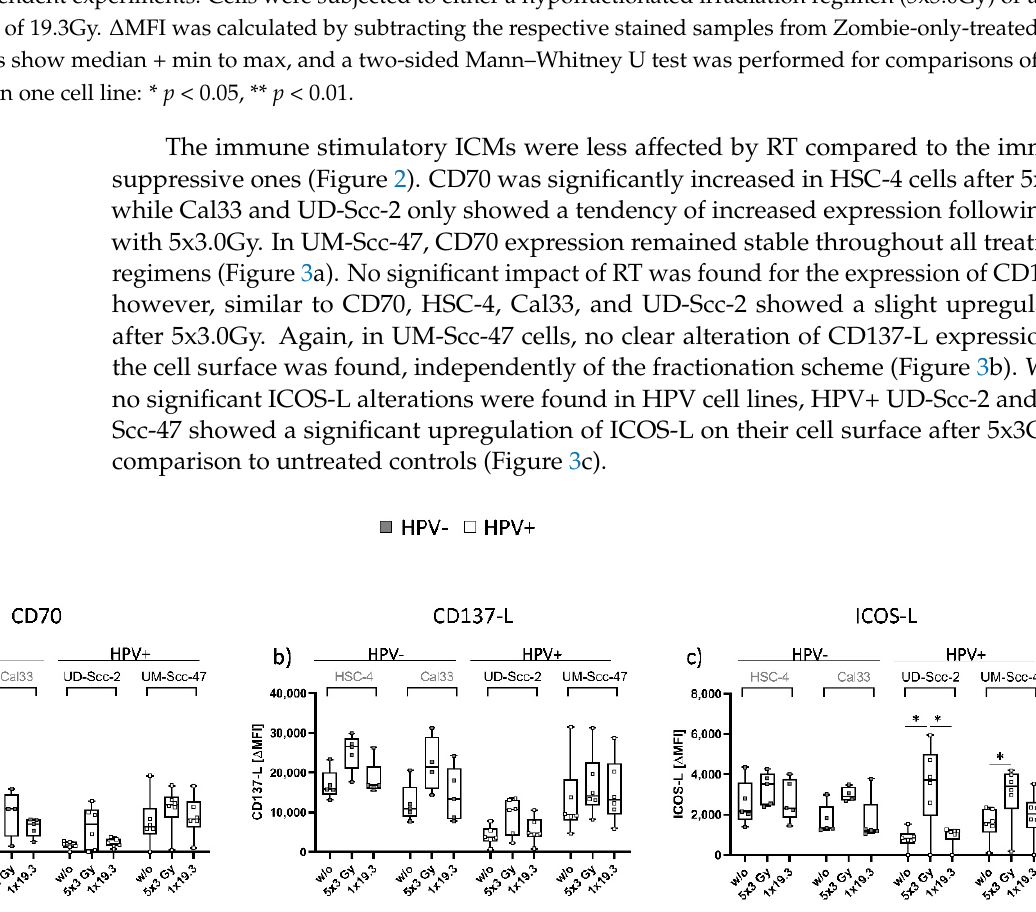
Figure 3. Cell surface expression of immune stimulatory checkpoint molecules CD70 ( a ), CD137-L ( b ) and ICOS-L ( c ) on the cell surface of HPV-negative (grey dots) and HPV-positive (white dots) HNSCC cell lines with n hpv − = 5; n hpv+ = 6 biological independent experiments. Cells were subjected to either a hypofractionated irradiation regimen (5x3.0Gy) or a single high dose of 19.3Gy. ∆ MFI was calculated by subtracting the respective stained samples from Zombie-only-stained samples. Graphs show Median + min to max and a two-sided Mann–Whitney U test was performed for comparisons of treatments within one cell line: * p <